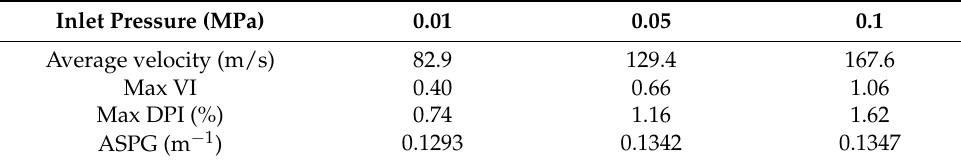
Table 6. Main index parameters for the test section with bicubic curve